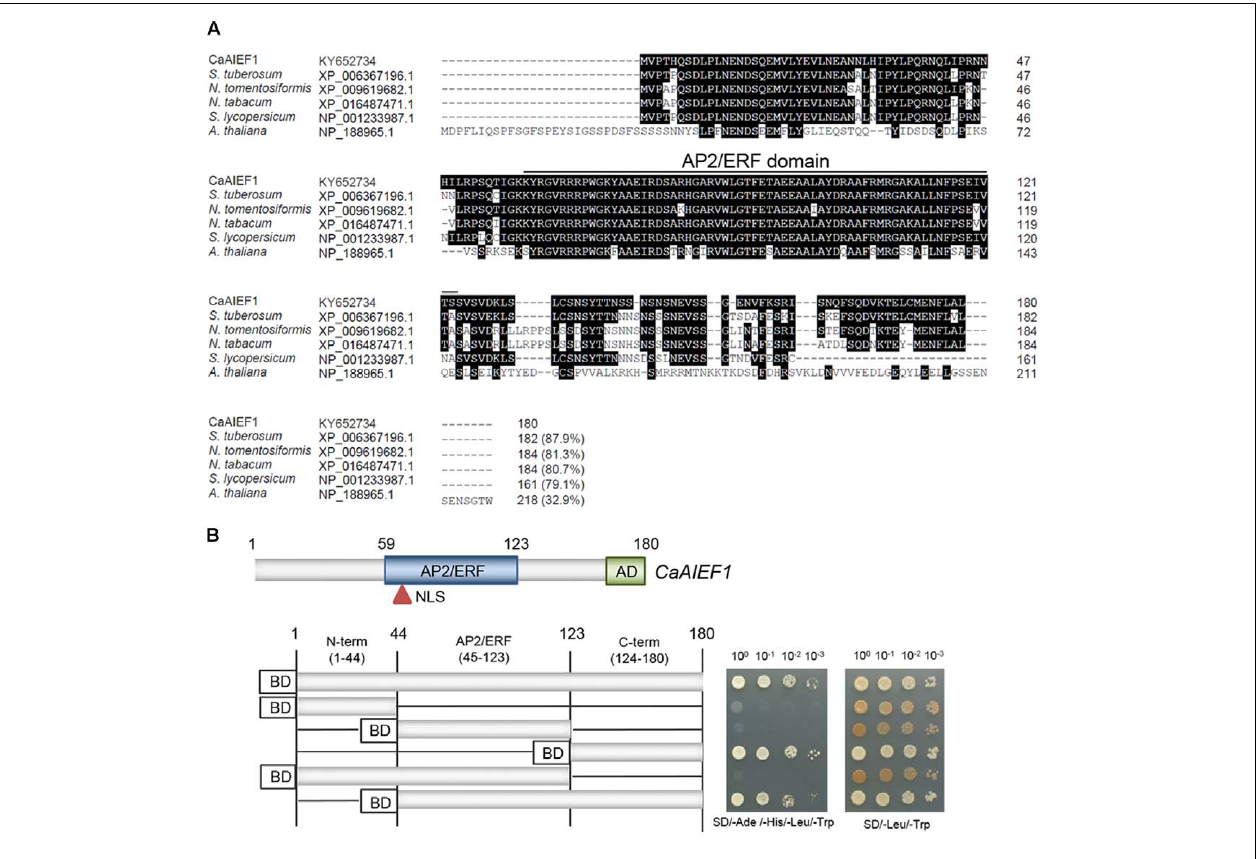
FIGURE 1 | Molecular characterization of the CaAIEF1 ( Capsicum annuum ABA Induced ERF 1) protein. (A) Comparisons of the deduced amino acid sequence of the CaAIEF1 protein with those of the Solanum tuberosum (accession no. XP_006367196.1), Nicotiana tomentosiformis (accession no. XP_009619682.1), N. tabacum (accession no. XP_016487471.1), Solanum lycopersicum (accession no. XP_001233987.1) and Arabidopsis thaliana (accession no. NP_188965.1) proteins. Identical amino acid residues are highlighted in black, and the upper line indicates the AP2/ERF domain. (B) Transactivation of GAL4-responsive transcription by the full-length and truncated forms of the CaAIFF1 gene using a GAL4 yeast system. Derivatives of S. cerevisiae strain AH109 harboring plasmids that encode GAL4-CaAIFF1 were grown on SD medium lacking adenine, histidine, leucine, and tryptophan (SD-adenine-histidine-leucine-tryptophan; left) or leucine and tryptophan (SD-leucine-tryptophan, right). Plates were incubated at 28 ◦ C for 5 days. pGBKT7 indicates the vector used in this experiment; this vector expressed GAL4